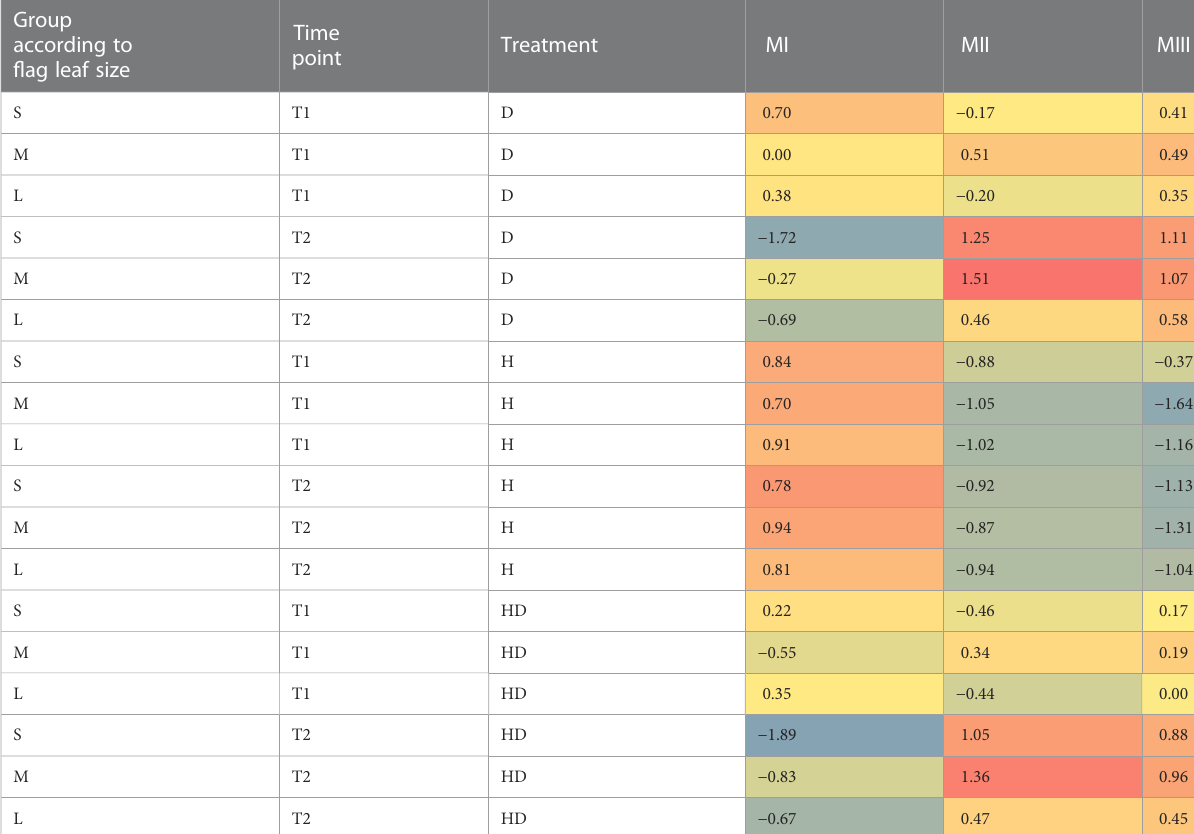
TABLE 3A Joined co-reaction modules containing DEGs with the most similar expression reaction induced by stress. Group